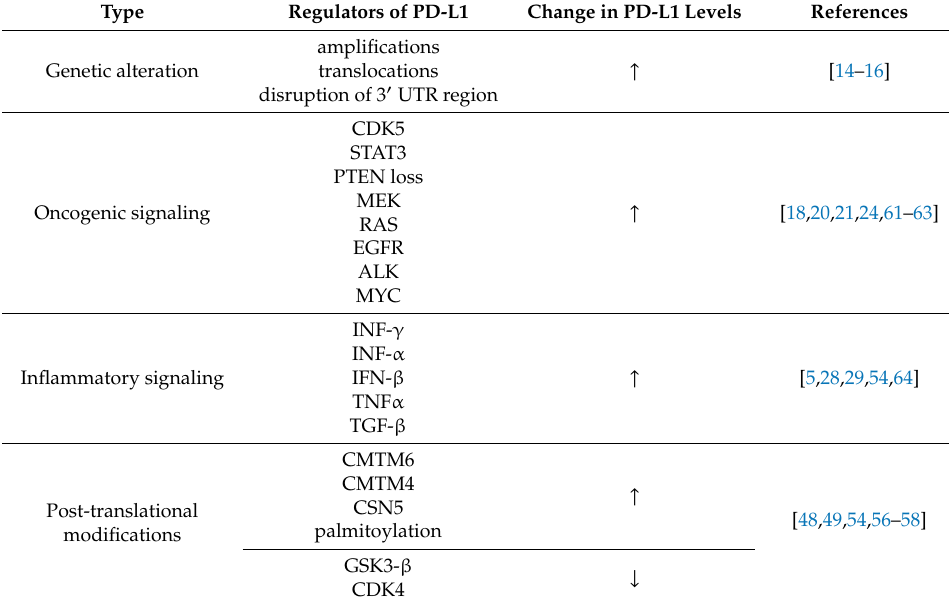
Table 1. Regulators of